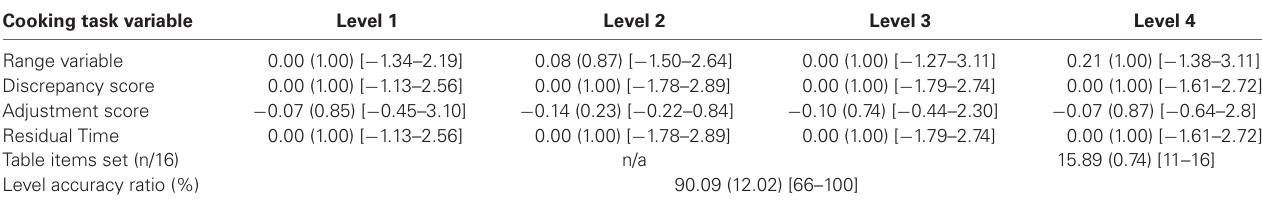
Table 3 | Standardized (Z) scores: Mean (SD) and [Range] values, for easy, moderate, difficult and dual-task levels of the cooking task indices with outliers removed ( n = 45 for adjustment variable across all levels, n = 46 for all other variables) . Cooking task variable